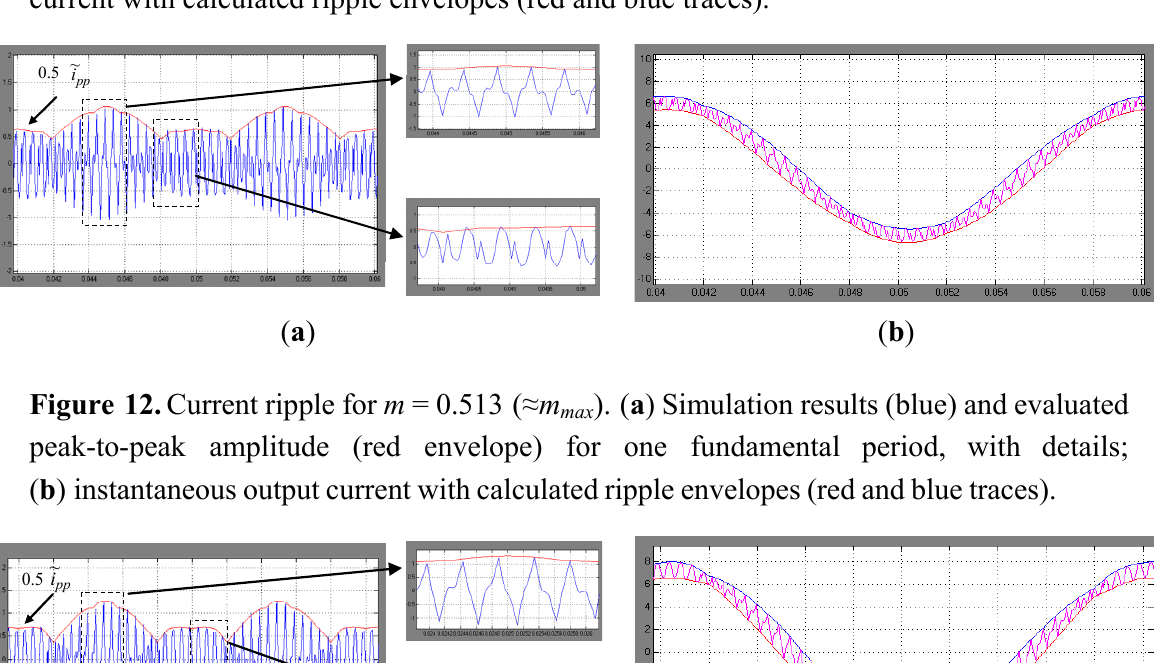
Figure 11. ( a ) Current ripple for m = 3/7. Simulation results (blue) and evaluated peak-to-peak amplitude (red envelope) for one fundamental period, with details; ( b ) instantaneous output current with calculated ripple envelopes (red and blue traces).